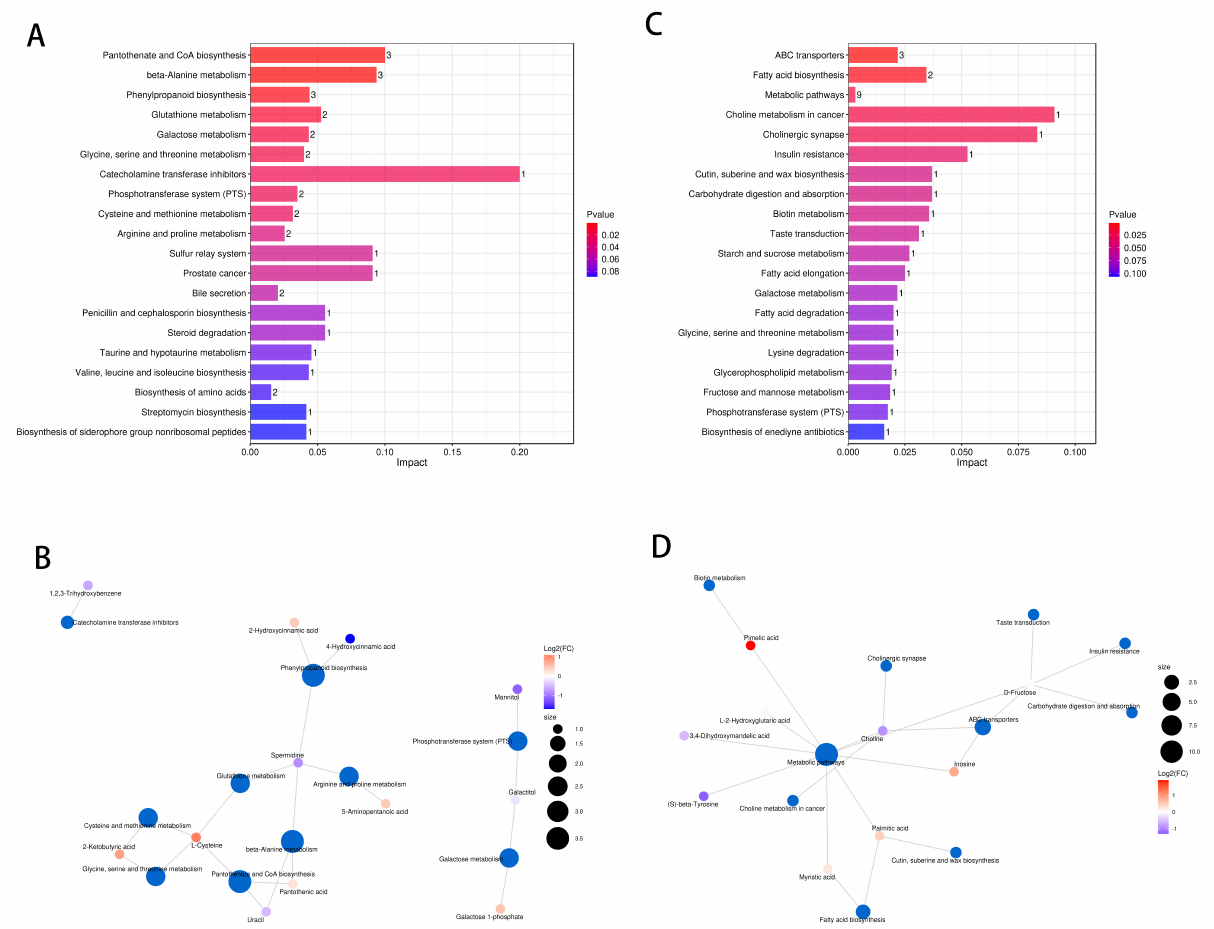
Figure 7. Pathway analysis of DXXK protecting myocardial cells from DOX-induced injury. ( A ) En- richment analysis of signaling pathways between the control group and DOX group. ( B ) Enrichment analysis of signal pathway between the DOX group and DXXK group. ( C ) The “Pathway-Metabolite” network of DOX-induced myocardial cell damage. ( D ) The “Pathway-Metabolite” network of DXXK protecting myocardial cell